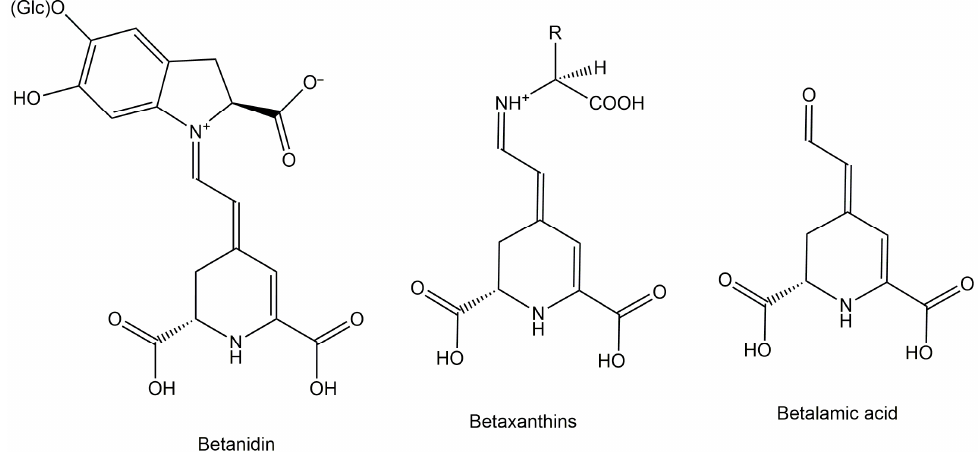
Figure 4. Structures of betanin, betaxanthins and betalamic acid.